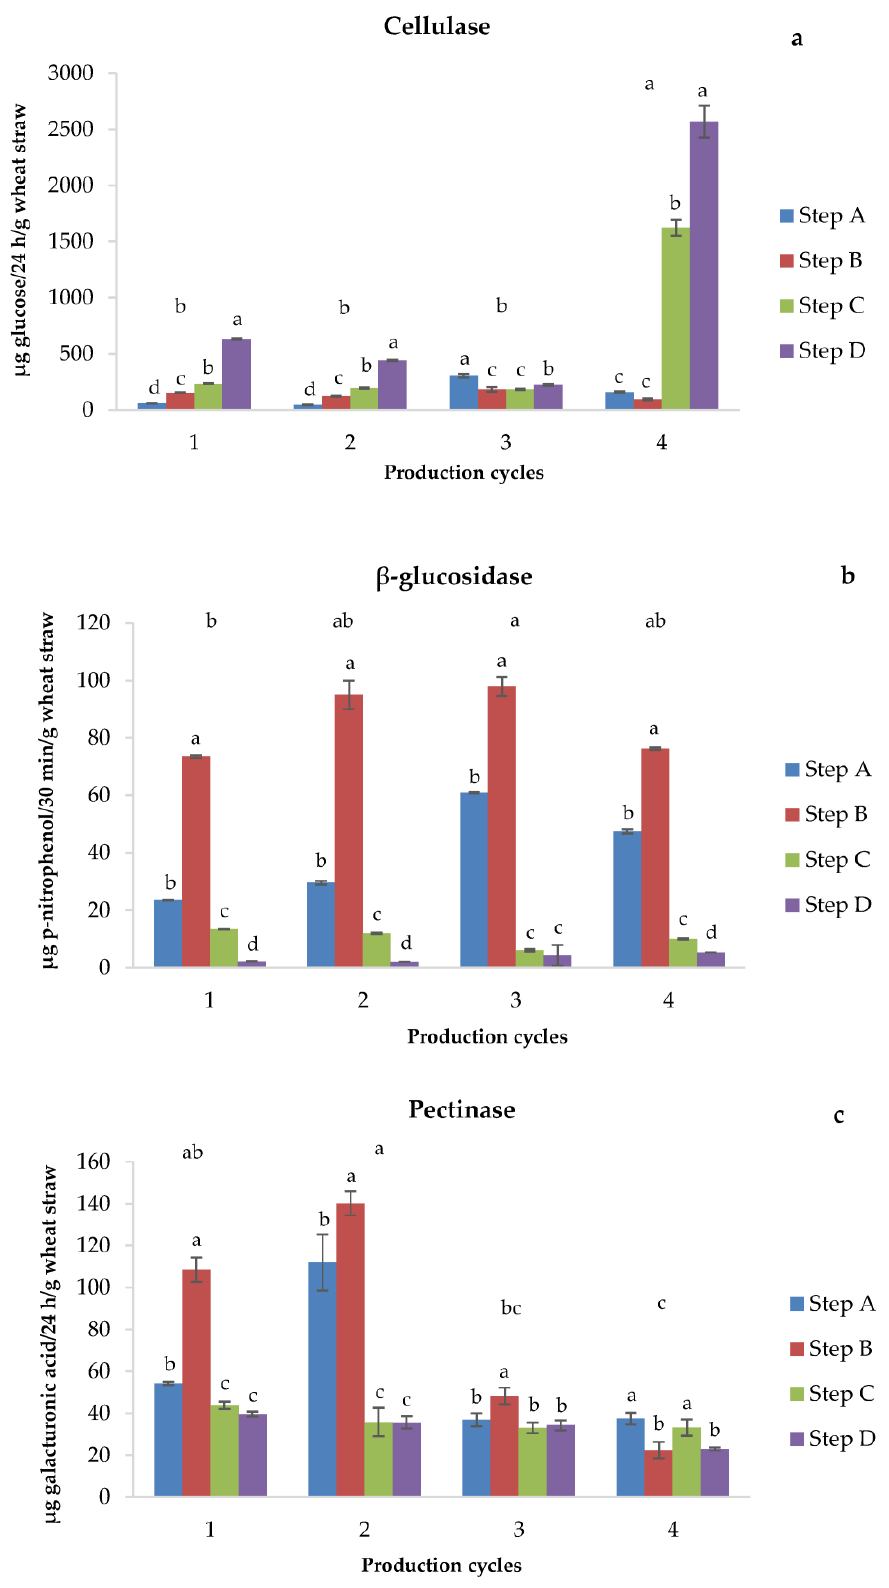
Figure 4. Cellulase ( a ), β-glucosidase ( b ), and pectinase ( c ) activities. Different letters above produc- tion cycles indicate significant ( p < 0.05) differences among them. Different letters above each bar indicate significant ( p < 0.05) differences among steps of the same production cycle.